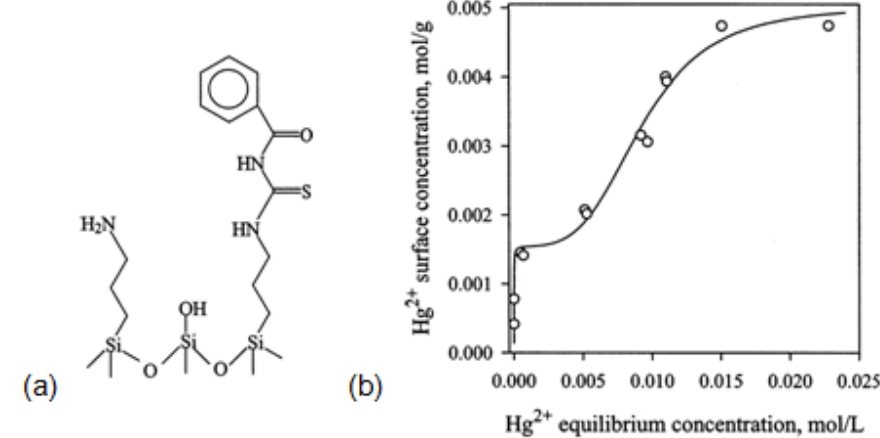
Figure 13. ( a ) Functional groups of MCM–41BTU and ( b ) adsorption isotherm for adsorption of Hg 2+ on MCM–41 BTU. The initial sharp part of adsorption isotherm is related to adsorption by 3-aminopropyl residuals. Reprinted with permission from